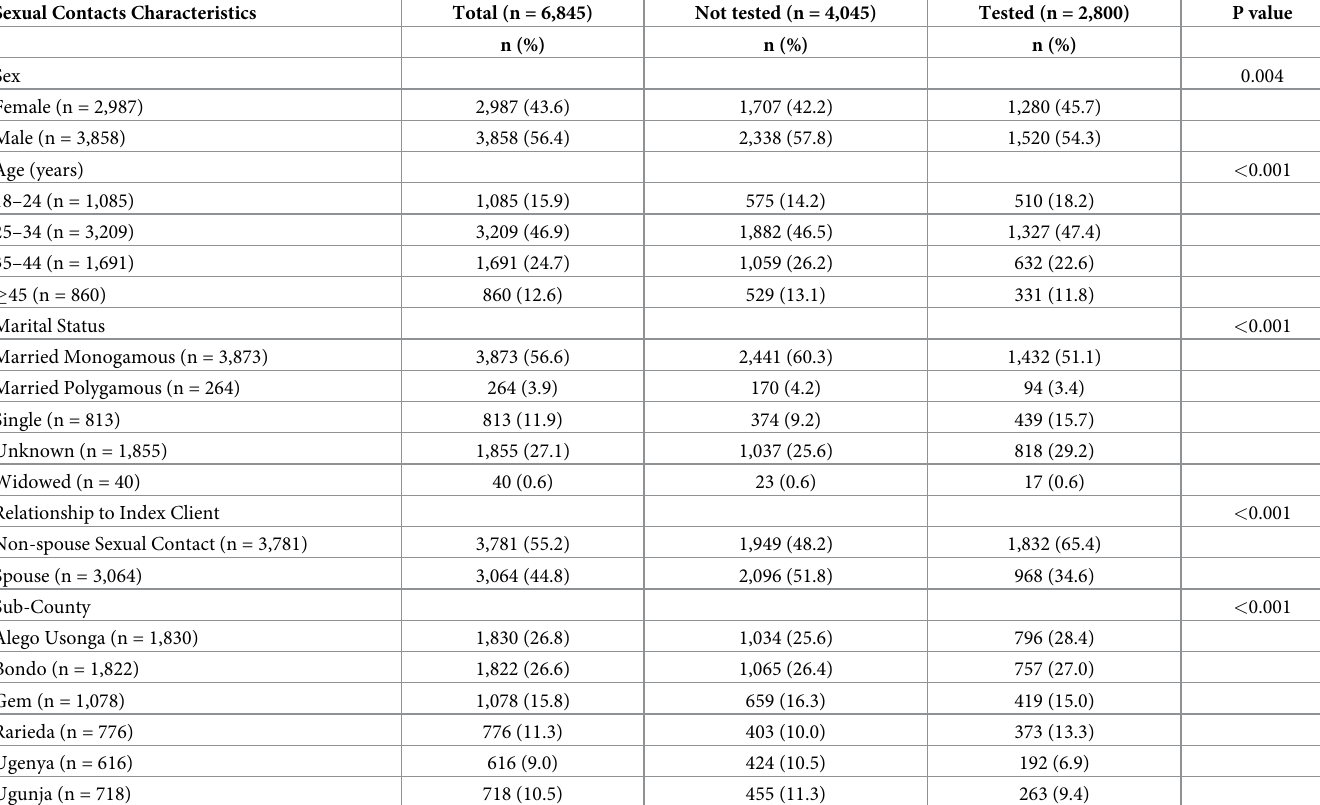
Table 1. Characteristics of sexual contacts of HIV-positive index clients and HIV testing uptake in Siaya County, Kenya. Sexual Contacts